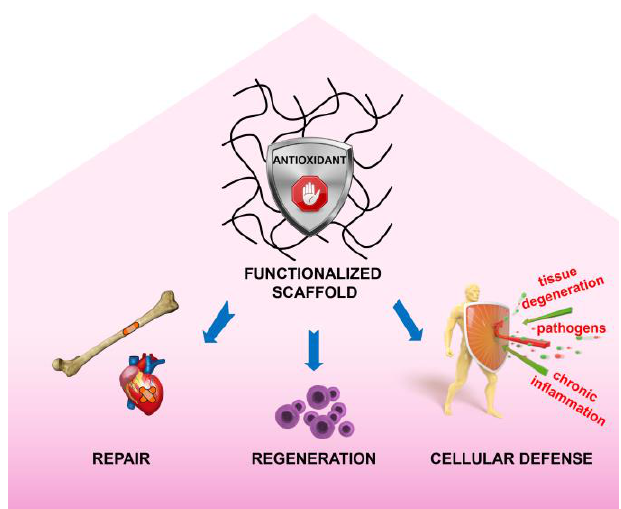
Figure 6. Schematic representation of the beneficial effects (repair, regeneration, and cellular defense) mediated by biomaterials incorporating natural antioxidants and demonstrated by their experimental application in tissue engineering and other therapeutic interventions.